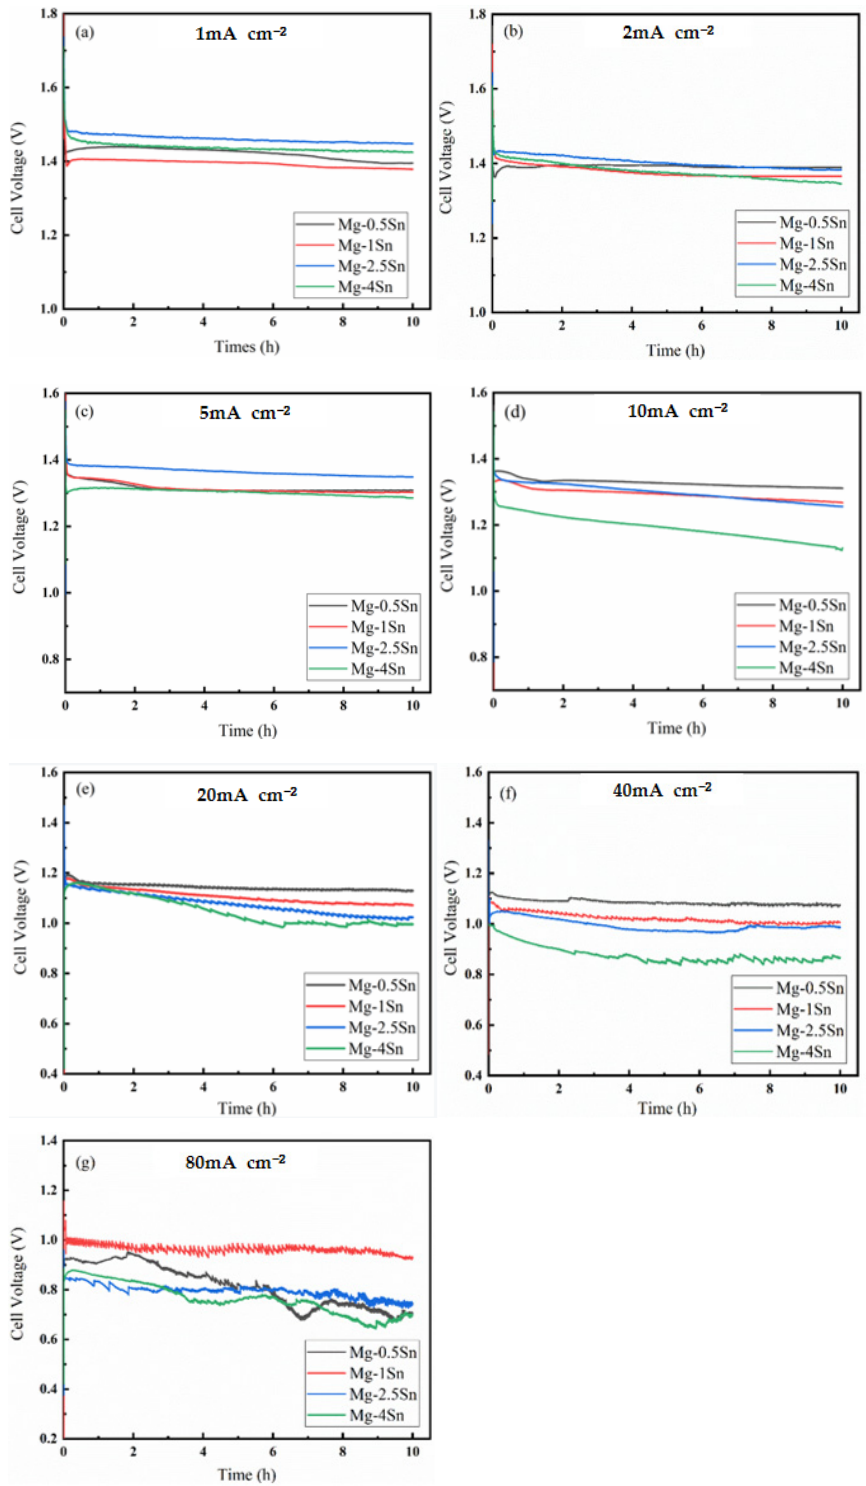
Figure 7. Discharge curves of the Mg − x Sn alloys anodes in 3.5 wt.% NaCl solution for 10 h at a current density of: ( a ) 1 mA cm − 2 , ( b ) 2 mA cm − 2 , ( c ) 5 mA cm − 2 , ( d ) 10 mA cm − 2 , ( e ) 20 mA cm − 2 , ( f ) 40 mA cm − 2 and ( g ) 80 mA cm − 2 . Table 5. Average discharge voltage of the studied anode at different current densities.